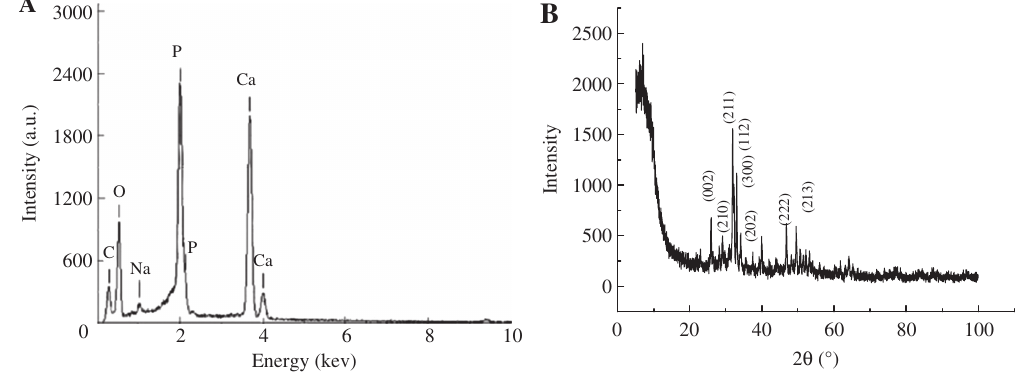
Figure 4 (A) EDS and (B) XRD results of the HA coating.